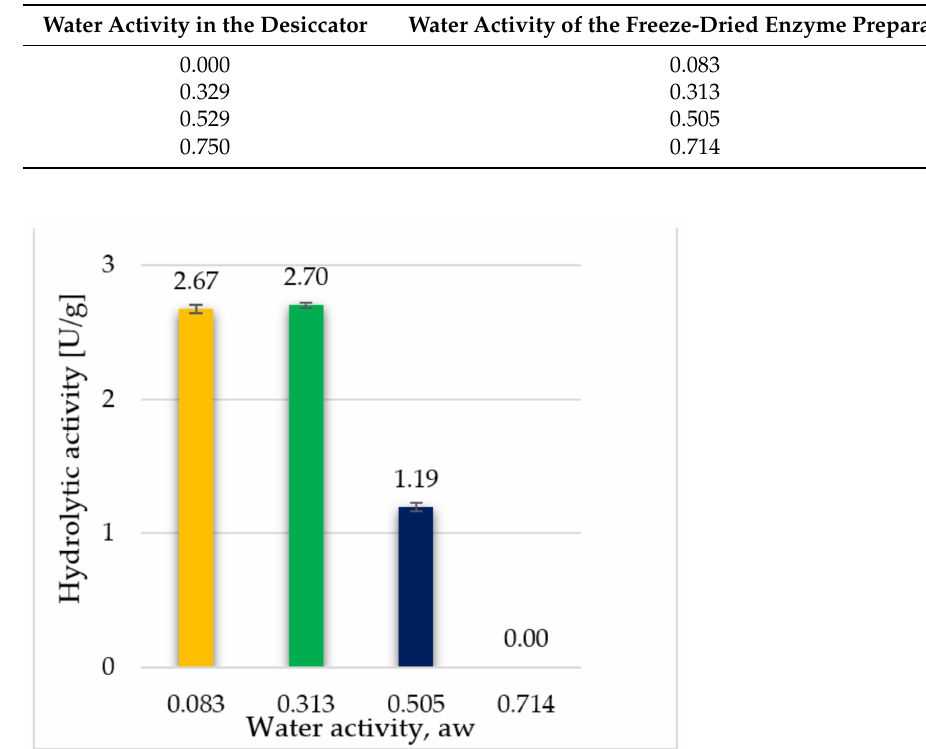
Table 2. The water activity of crude freeze-dried enzyme preparations incubated in controlled atmosphere with various water activities.